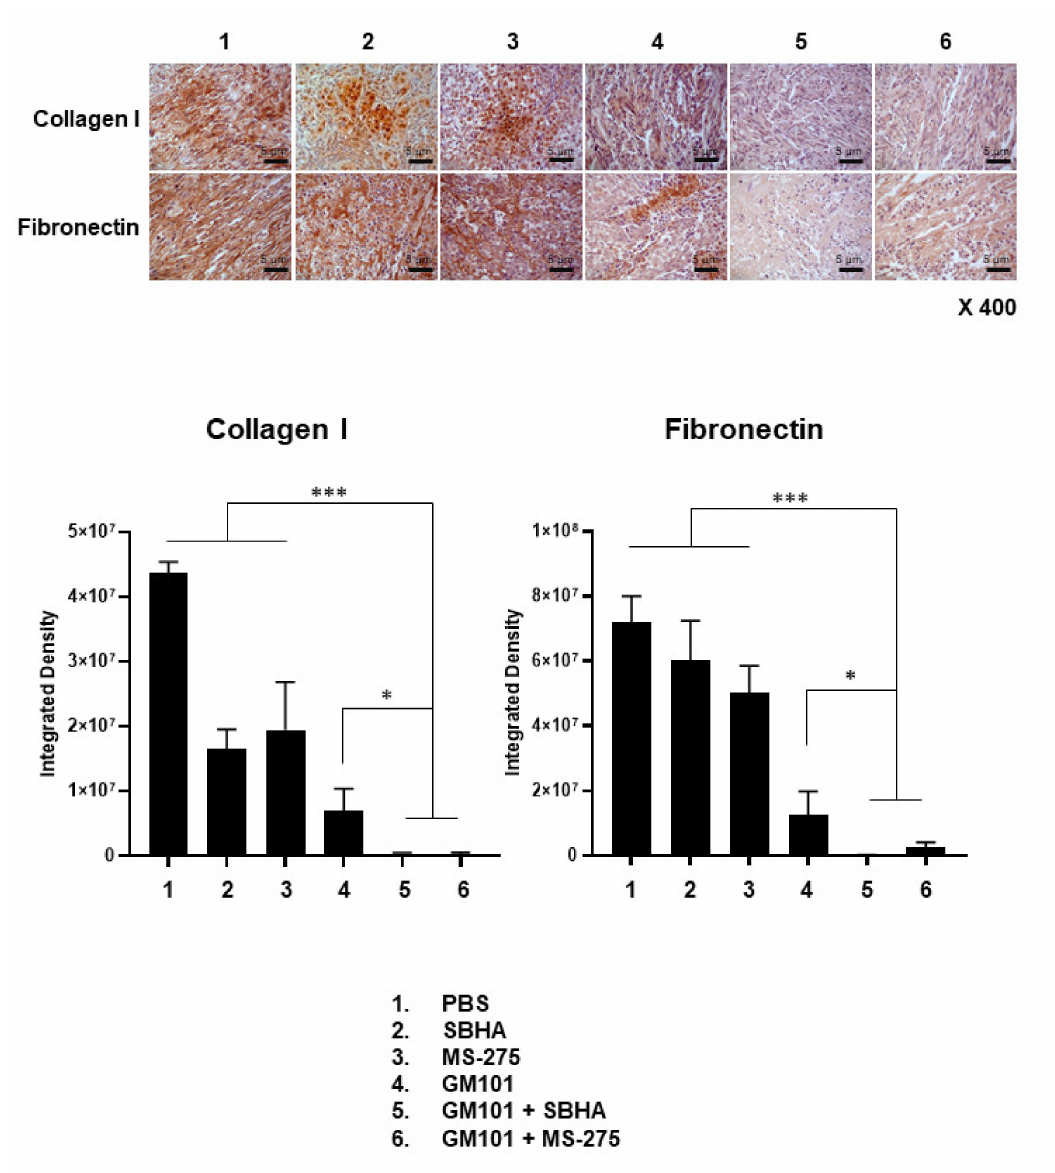
Figure 7. Histological and immunohistochemical analysis of extracellular matrix composition of tumor tissues. U343 xenograft tumors were established in nude mice through subcutaneous injection to the abdominal skin. Once the average tumor volume reached 100 mm 3 , tumor-bearing mice were treated with PBS, SBHA (200 mg/kg), MS-275 (20 mg/kg), GM101 (5 × 10 9 VP), GM101+SBHA, or GM101+MS-275. Tumor tissues were harvested for histological and immunohistochemical analysis on the 9 th day after initial treatment. Tumor sections were stained with collagen I- or fibronectin-specific antibodies. Representative images are shown. Original magnification: × 400. The scale bar represents 5 µ m. Immunohistochemical staining results were semi-quantitatively analyzed using ImageJ analysis software. Data are presented as the mean integrated optical density ± SD ( n = 3 mice per group; optical density was analyzed from five random fields). * P < 0.05 , *** P < 0.001